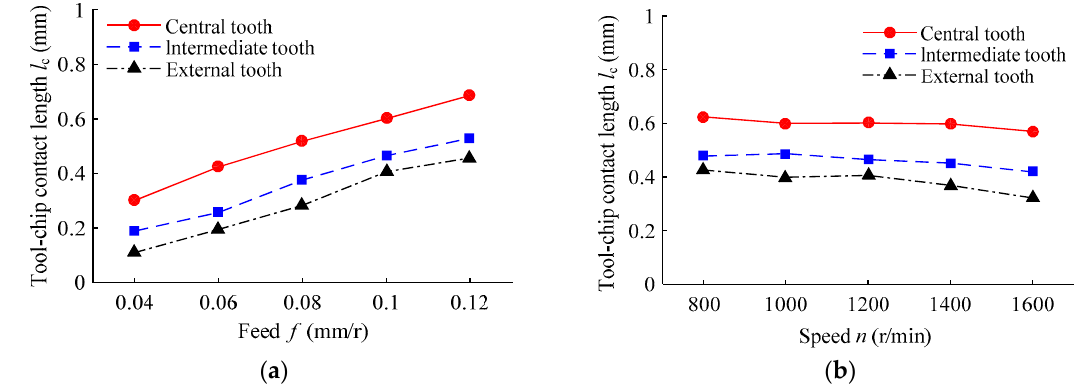
Figure 12. Distribution of the tool–chip contact length along cutting radius.